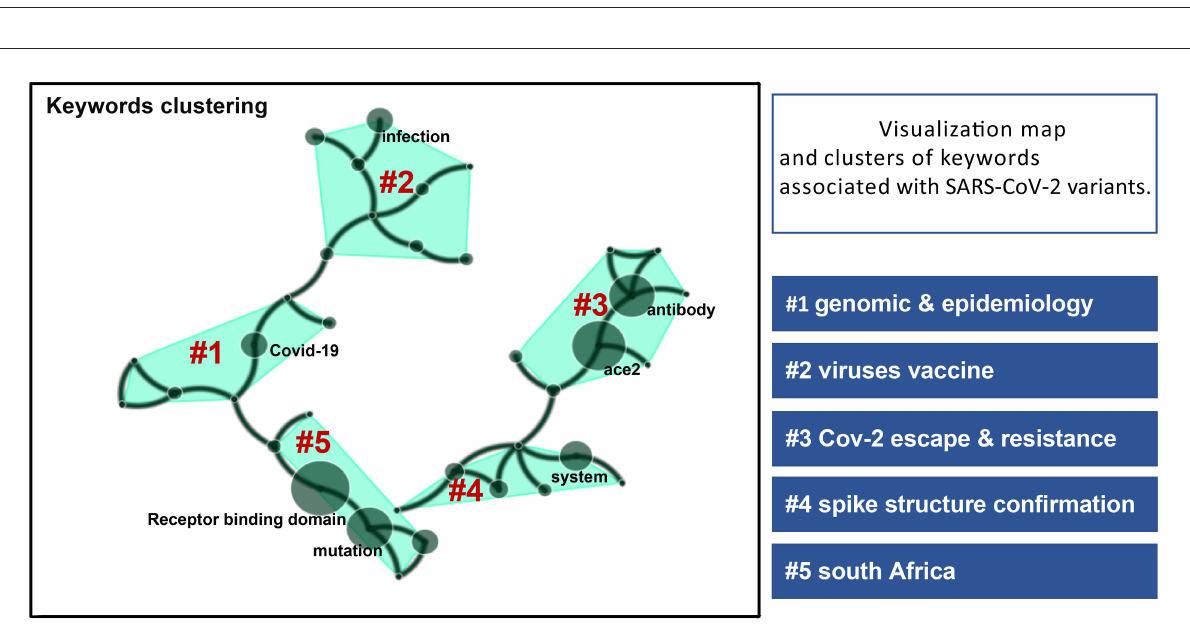
FIGURE7 Visualization map and clusters of keywords associated with SARS-CoV-2 variants and corresponding clusters based on research direction. The size of the circles indicates the frequency of keyword occurrences.